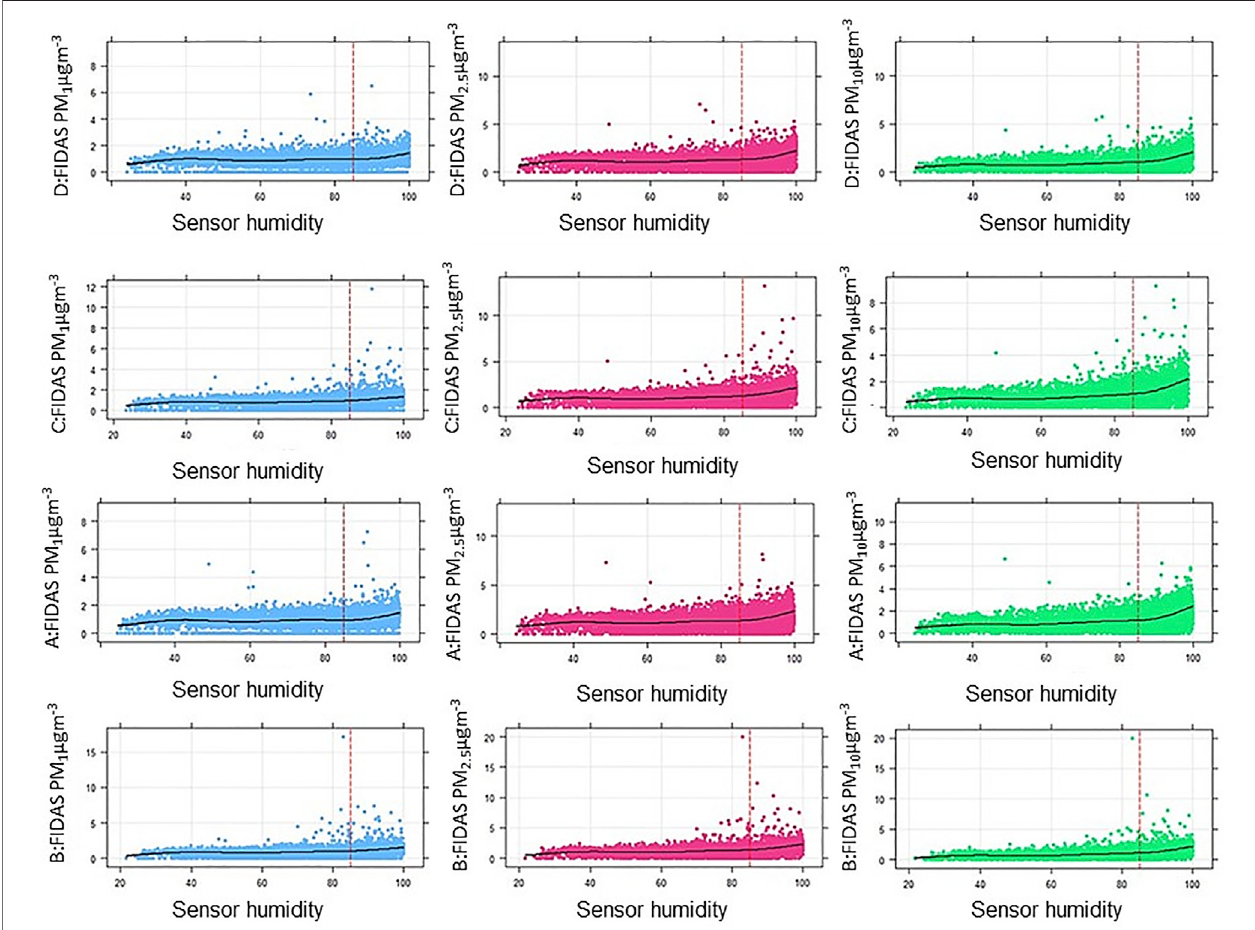
FIGURE 5 | Ratio of Altasense PM concentrations/FIDAS PM concentrations vs . humidity, with 85% humidity marked in red.